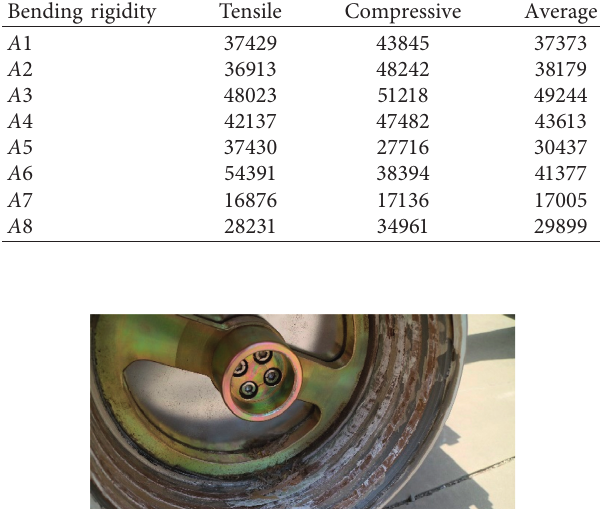
Figure 4: Change of bending moment with the rotation angle in individual insulator A6 at the (a) tension side and (b) compression side. Table 3: Bending rigidities of individual insulators. Table 4: Test parameters for flange bending rigidity of composite pillar